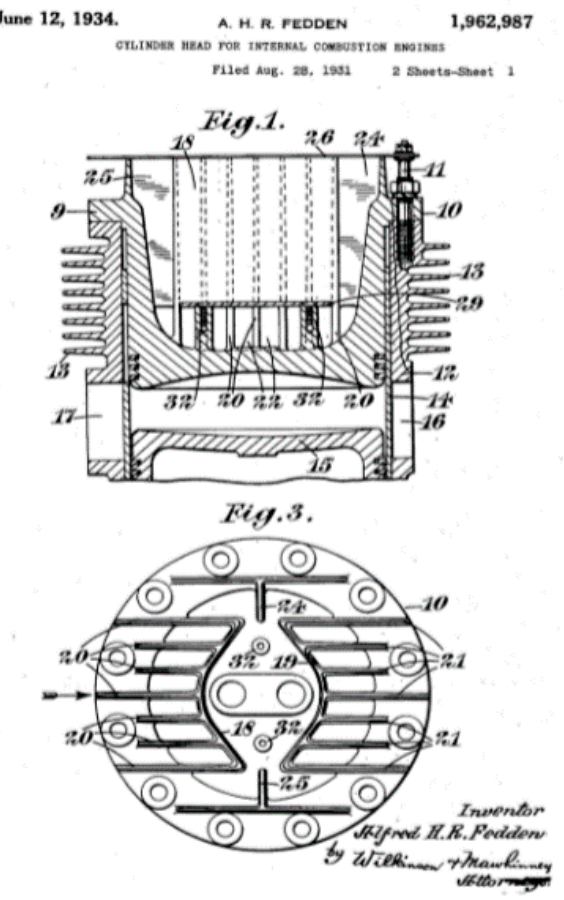
Figure 26. A.H.R Fedden, Bristol Aeroplane Company Cylinder head for internal combustion